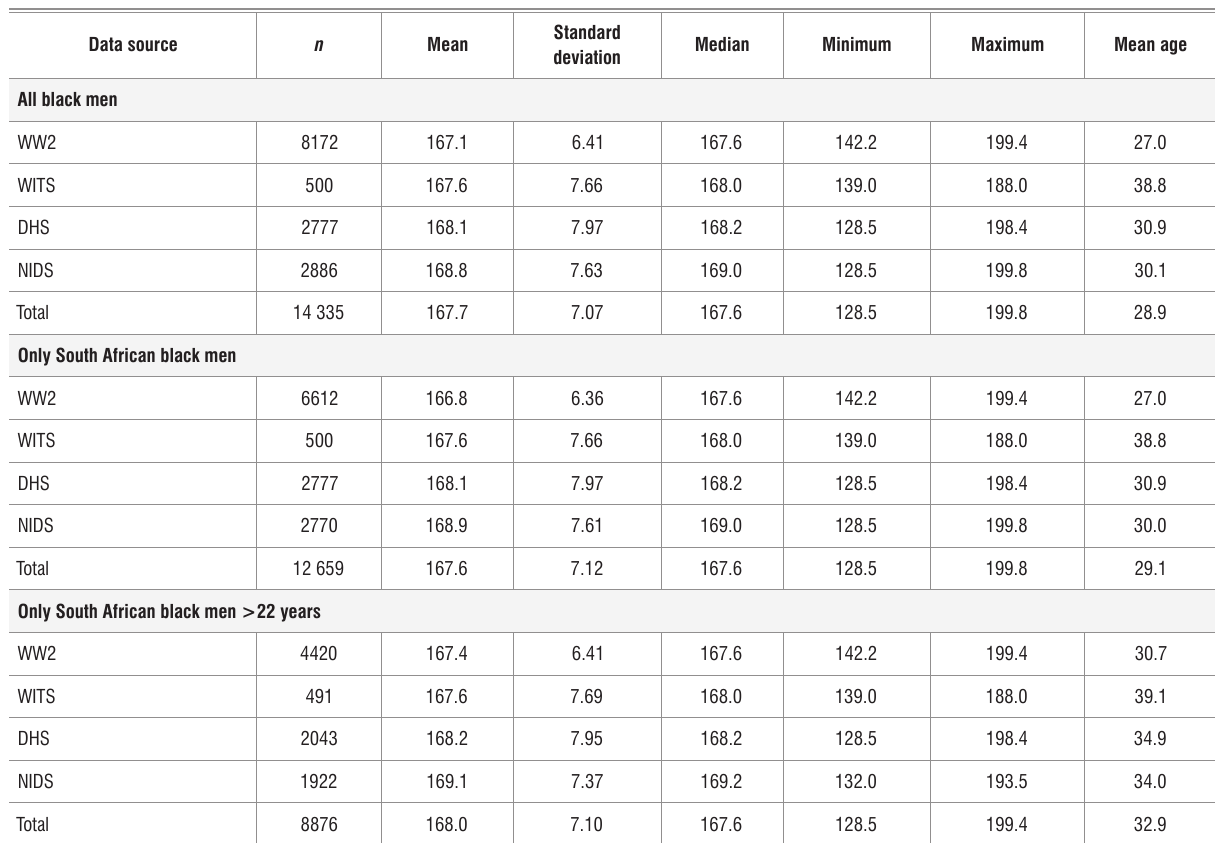
Summary of the statistics relating to heights of black men from four data sources Data